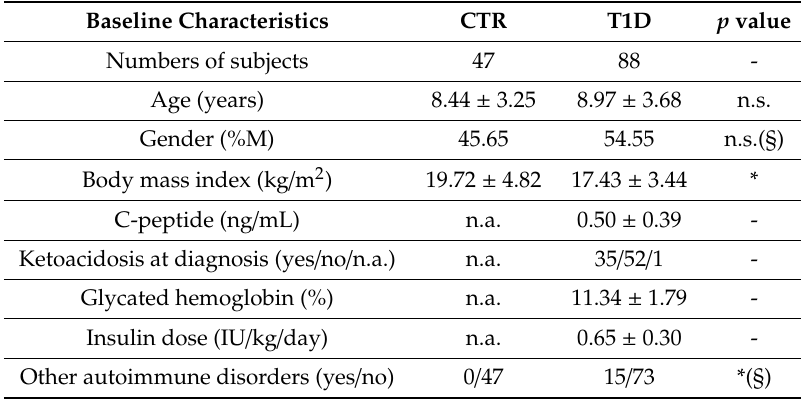
Table 1. Baseline characteristics of type 1 diabetes (T1D) children at diagnosis and healthy controls (CTR) recruited for the study. Comparisons were performed using either Student’s t -test or a Chi-squared test (§). Legend: n.s., not significant; n.a., not available. * p <